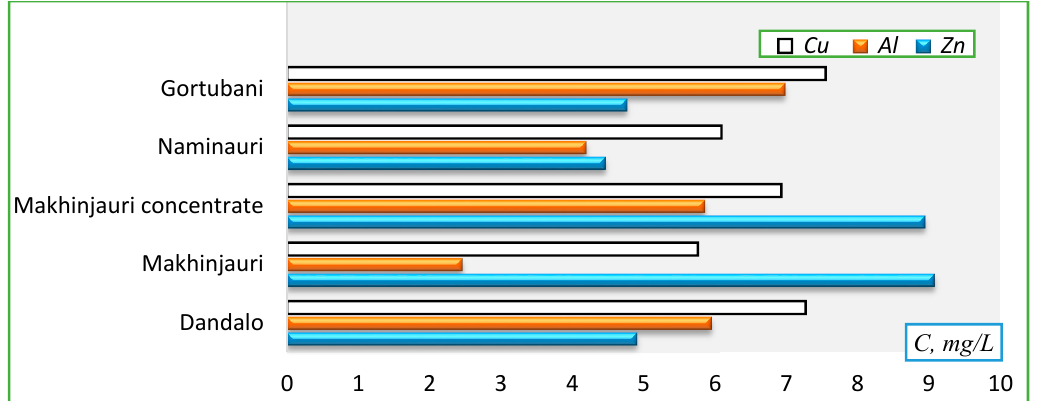
Figure 15. The content of Si, Hg and V in the mineral waters.